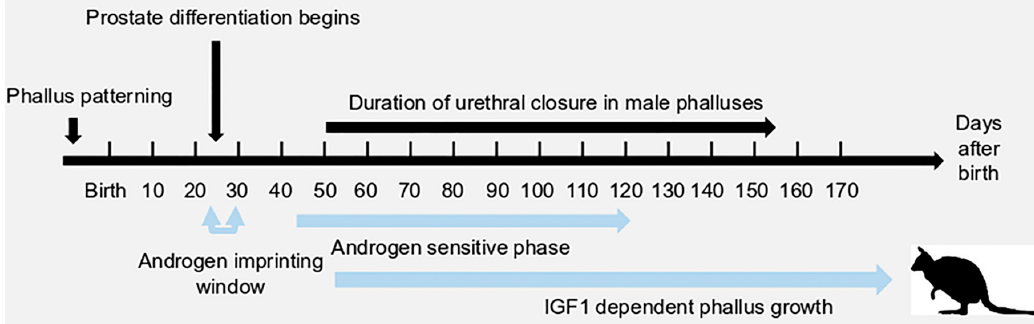
Figure 1. The timeline of prostate differentiation, phallus development, the androgen imprinting window, the androgen sensitive phase, and the insulin-like growth factor 1 ( IGF1) dependent phase in the tammar wallaby.